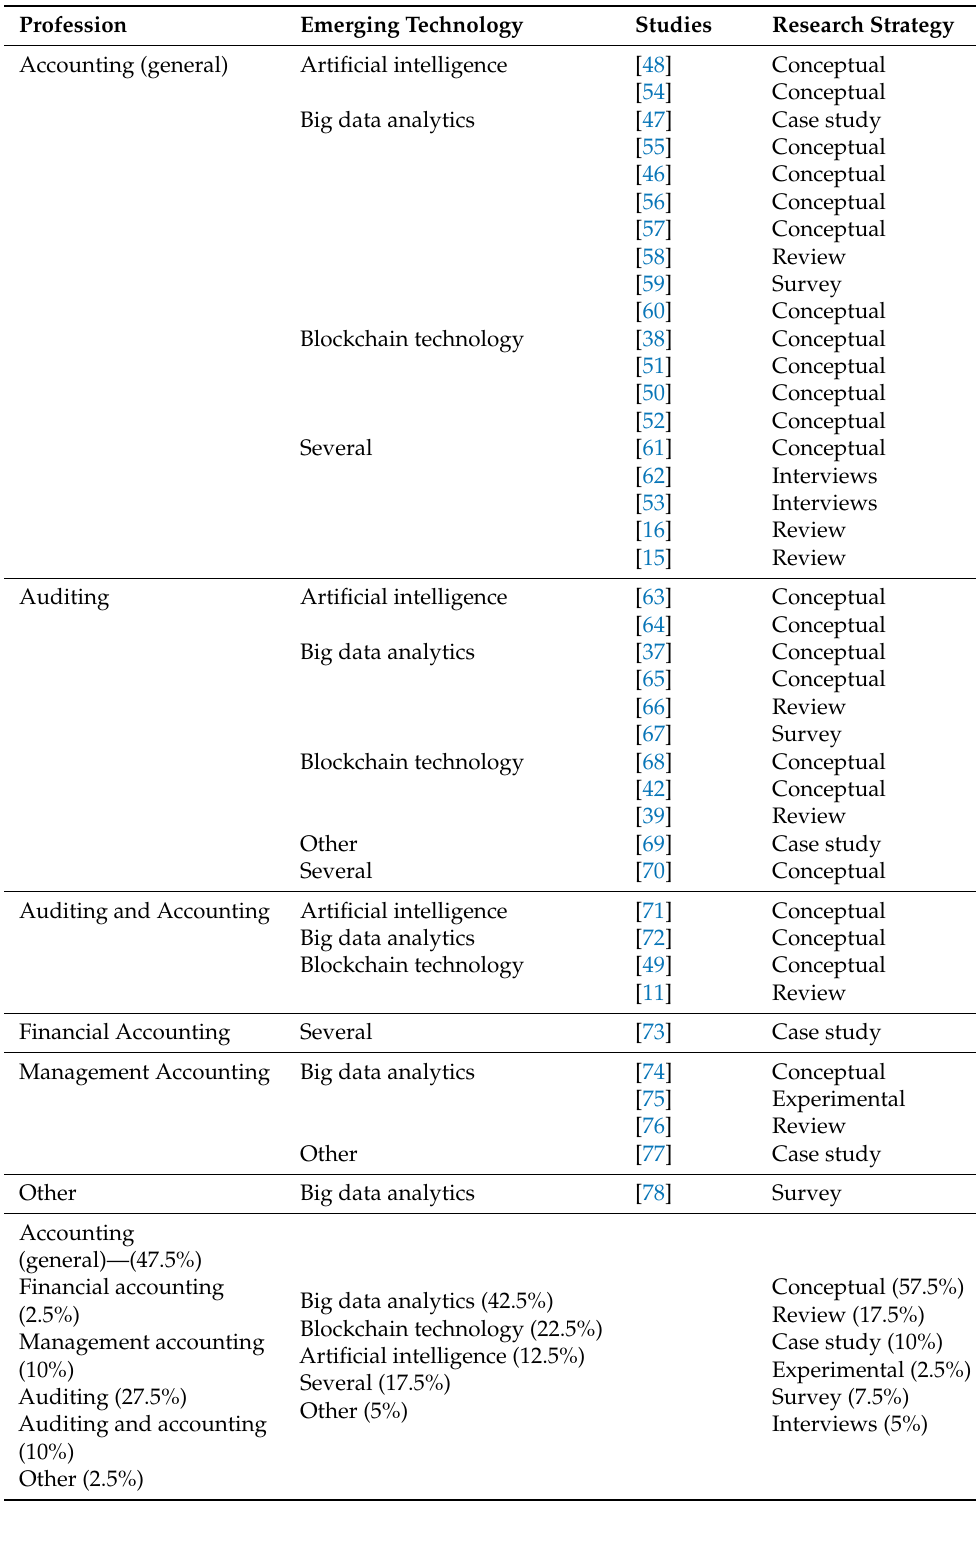
Table 2. Paper classification concerning profession, emerging technology, and research